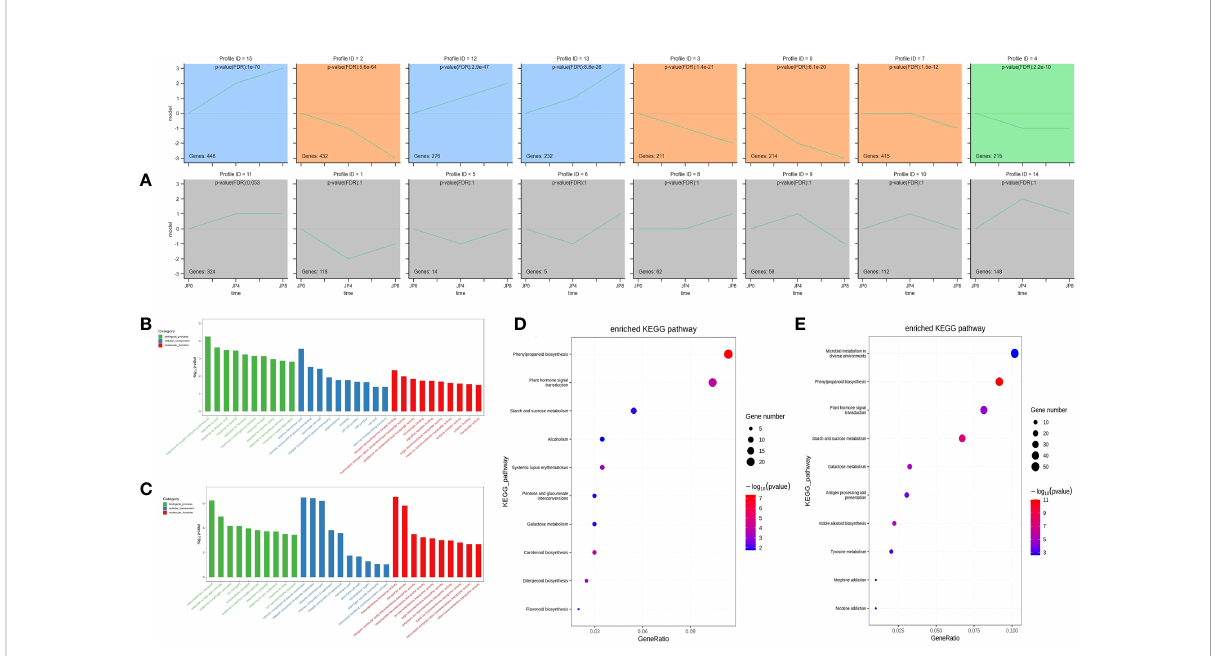
FIGURE 3 GO and KEGG enrichment analysis across three time points during drought stress of maize plant roots. (A) Twenty representative pro fi les of different expression trends. The colored background parts showed signi fi cance, and the genes of the same type were gathered in the same cluster. (B, C) The most signi fi cantly enriched GO terms of DEMRs from the two comparison groups. (D, E) The most signi fi cantly enriched KEGG pathway of DEMRs from the two comparison